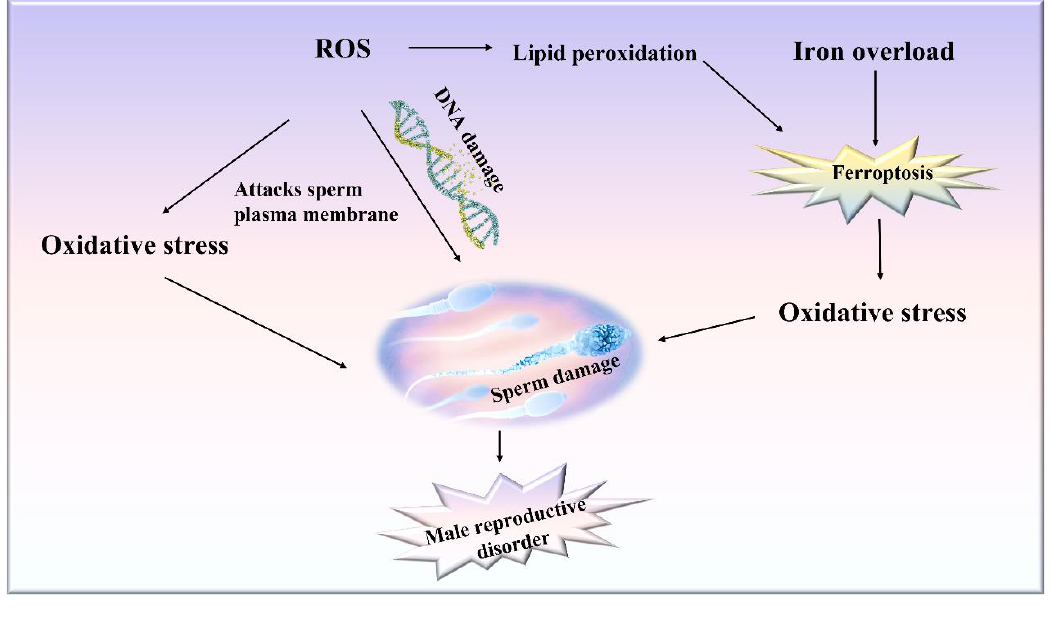
Figure 3. A schematic model describing the potential role of ferroptosis in triggering male spermat- ogenesis disorders.